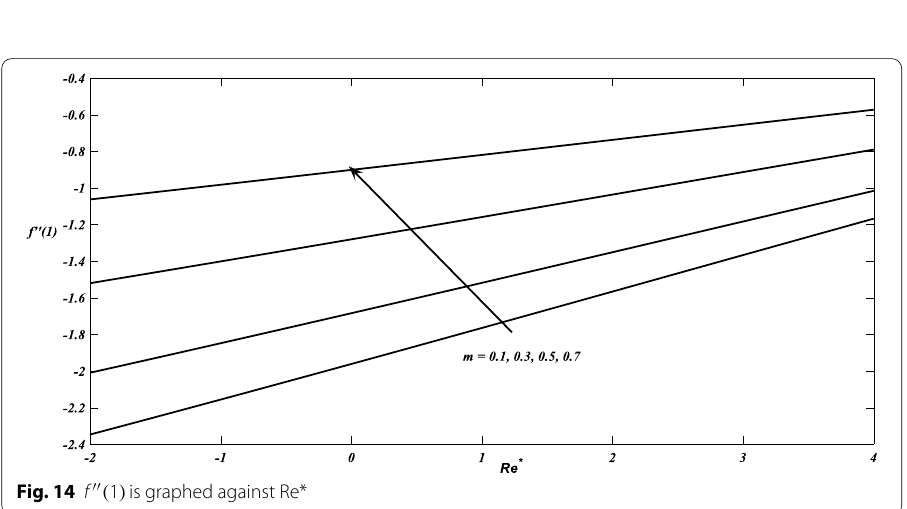
Fig. 14 f ′′ ( 1 ) is graphed against